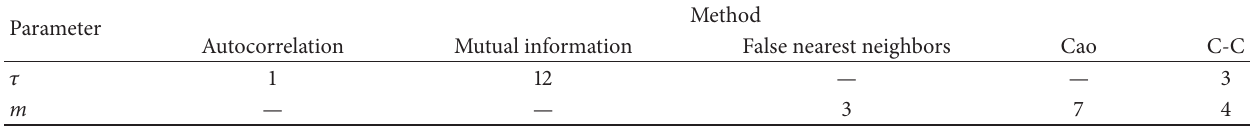
Table 4: Comparison among phase space reconstruction methods.